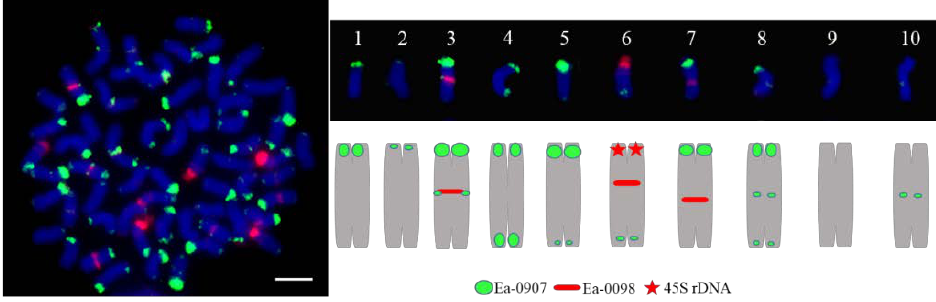
Figure 6. Chromosome karyotype of Hainan 92–105. Scale bars = 5 μm. Table 1. The different types of chromosomes based on repetitive sequence probes.